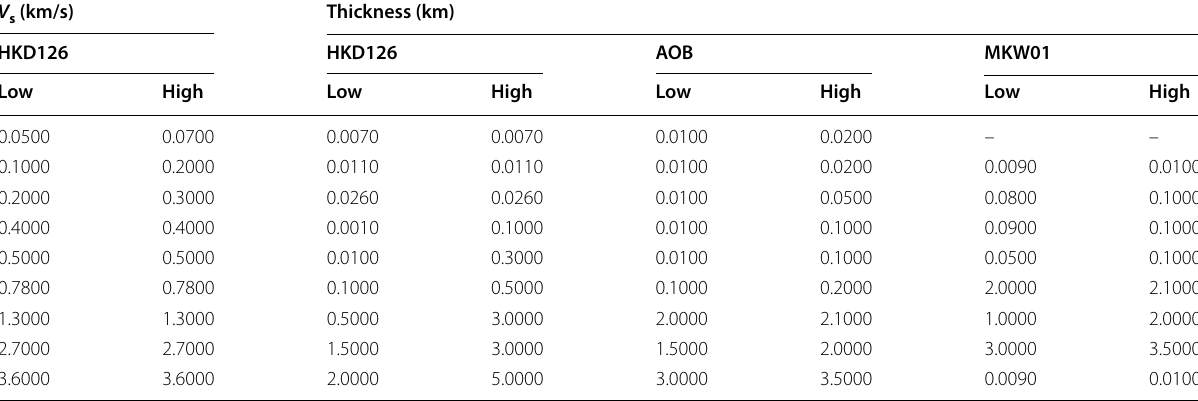
Table 2 Search range for inversion